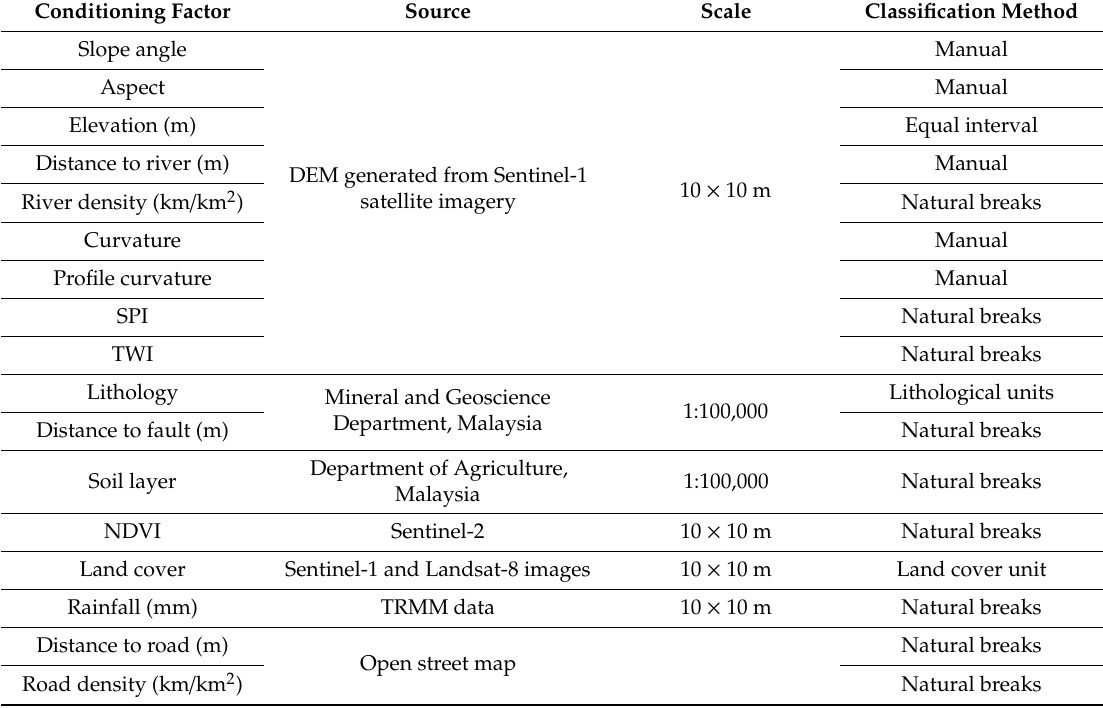
Table 1. Source and scales for the landslide conditioning factors used in this study. DEM: Digital Elevation Model, NDVI: Normalized Di ff erence Vegetation Index, SPI: Stream Power Index, TRMM: Tropical Rainfall Measuring Mission, TWI: Topographic Wetness